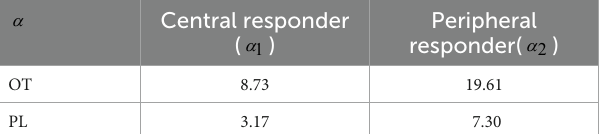
TABLE 3 Estimated values of α 1 and α 2 in OT and PL groups.